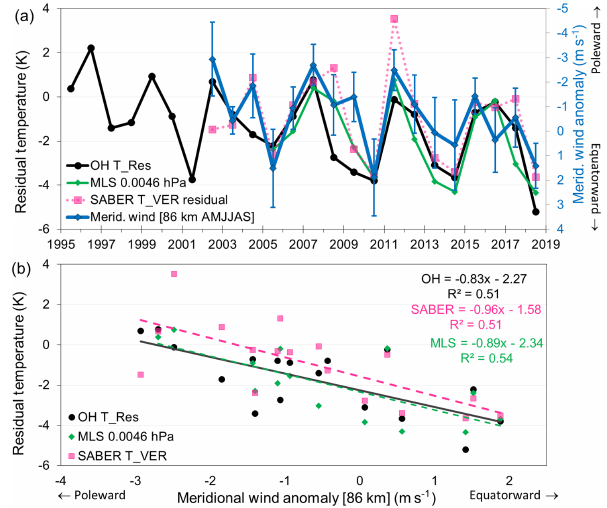
Figure 6. (a) Davis OH, Aura/MLS (0.0046hPa level) and SABER (T_VER) residual temperatures compared to the AMJJAS mean meridional wind at 86km measured by MFSA radar at Davis. (b) The relationship between Davis OH, Aura/MLS, and SABER residual temperatures and meridional winds at 86km above Davis. OH and SABER are fit over a common era (2002–2018) for com- parison. MLS is fit over 2005–2018.